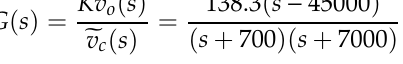
Figure 9. Comparison between measured (red) and curve-fitting (blue). Table 2. Electrical specifications and parameters of the prototype converter. Parameter/Description